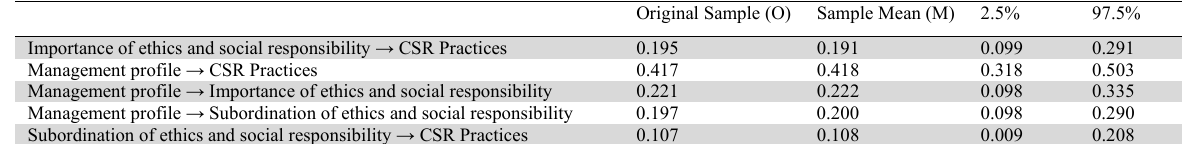
Confidence Intervals Importance of ethics and social responsibility → CSR